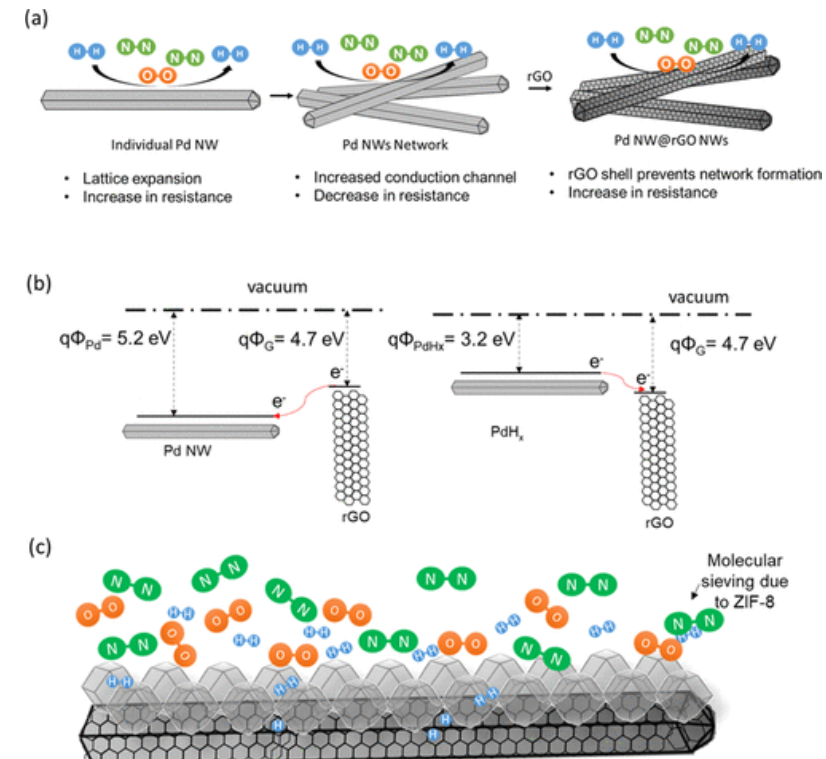
Figure 8. Pd NWs@rGO@ZIF − 8 composite. ( a ) Sensing mechanism; ( b ) energy band diagram of Pd NW and p-type rGO, and PdH x and p-type rGO; ( c ) molecular − sieving effect of ZIF − 8 in the Pd NWs@rGO@ZIF − 8 H 2 sensor. Reprinted with permission from Ref. [215]. Copyright 2021 American Chemical Society.